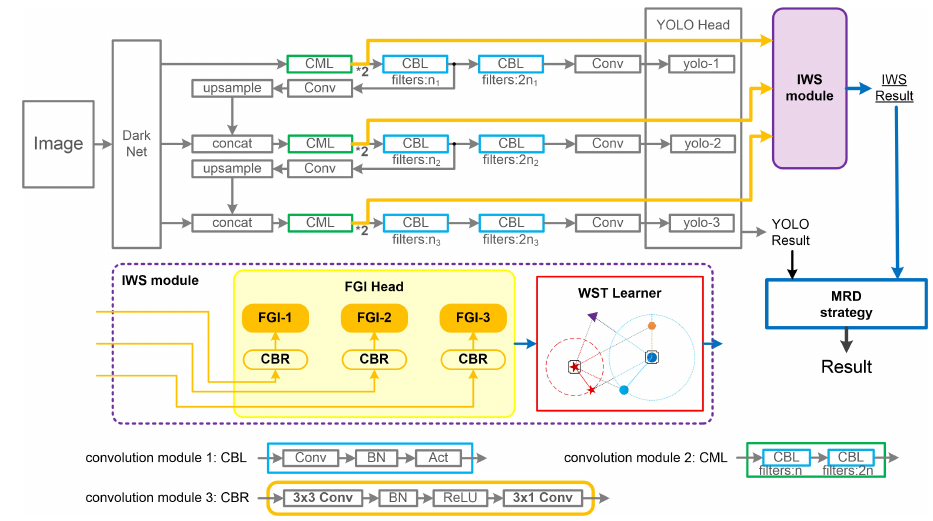
Figure 5. Core strategy of YOLO+IWS.